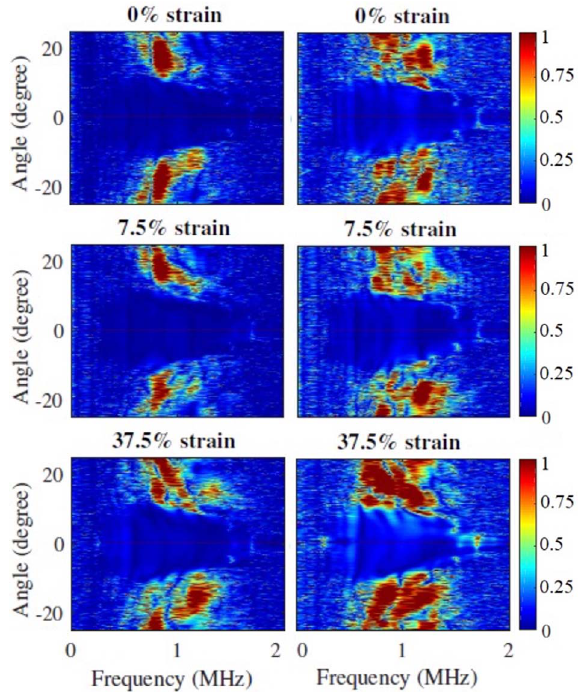
Figure 7. Normalized angular spectrograms were obtained in polar scans about the (left column) Y -axis and (right column) diagonal axis for the sample under 0%, 7.5% and 37.5% strains.